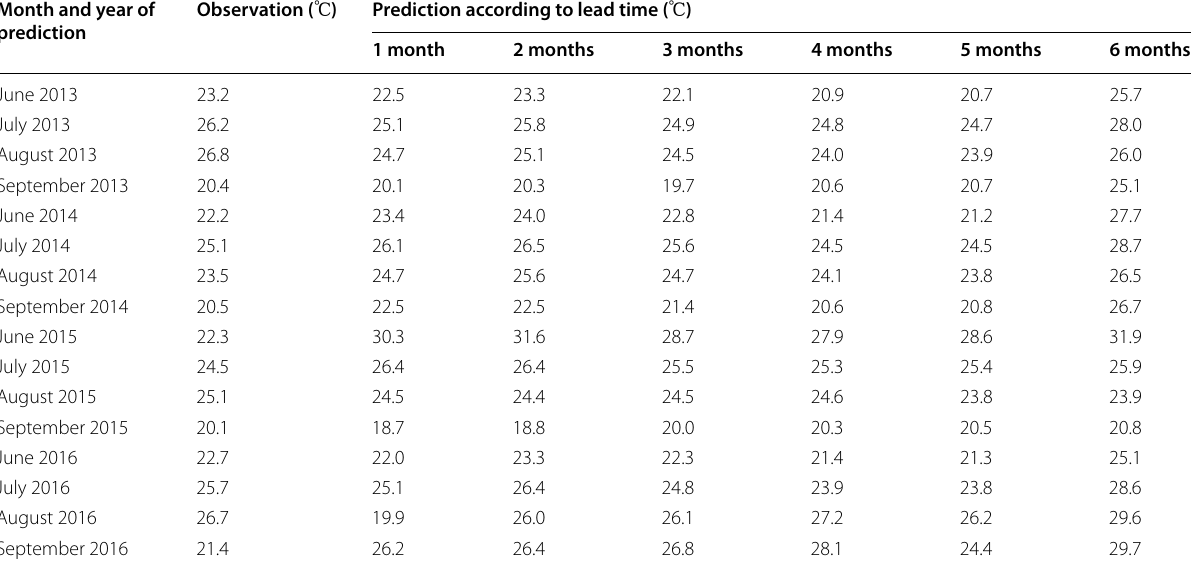
Table 9 Results of the temperature prediction model using the modified method Month and year of Observation ( ℃ ) Prediction according to lead time ( ℃ ) prediction